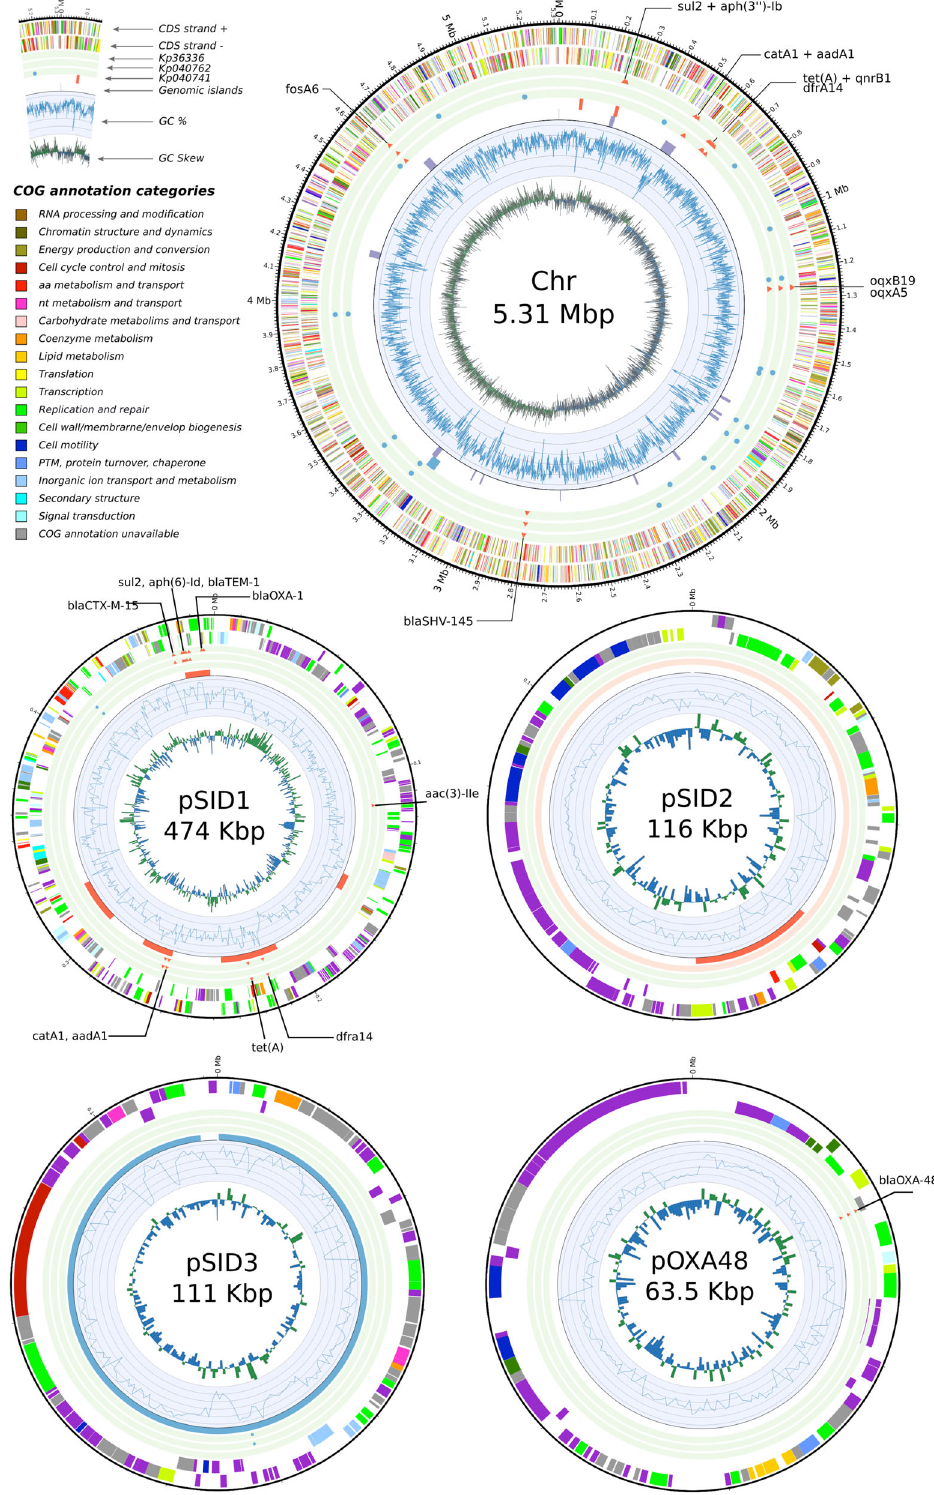
Fig. 5 Visualization of the functional content of the pandrug-resistant Klebsiella pneumoniae isolate Kp36336 among the different replicons. The antibiotic resistance genes (ARGs) and single nucleotide polymorphisms (SNPs), as well as the prophage content and genomic islands, found in the three distinct K. pneumoniae isolates were added (Supplementary Data 2 –